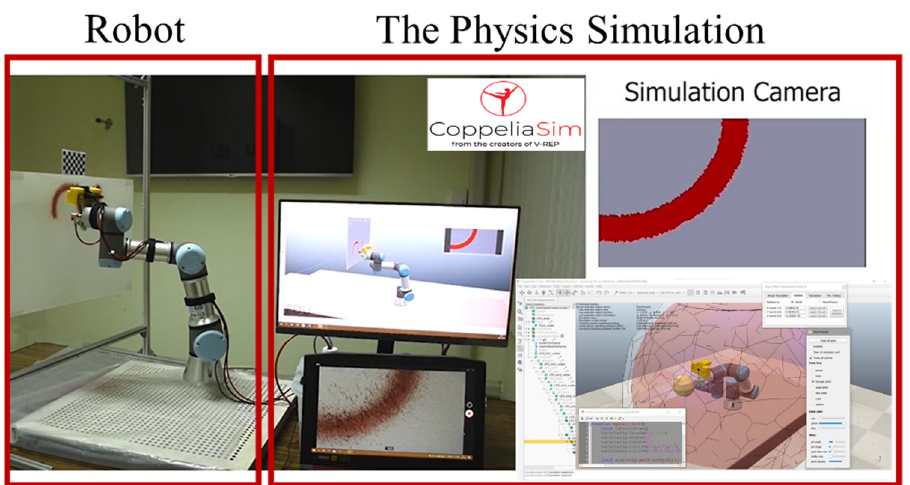
Figure 7. The Physics Simulation Program.